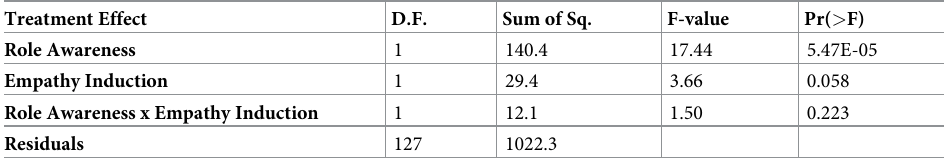
Table 3. A two-way analysis of variance (type II) on the treatment